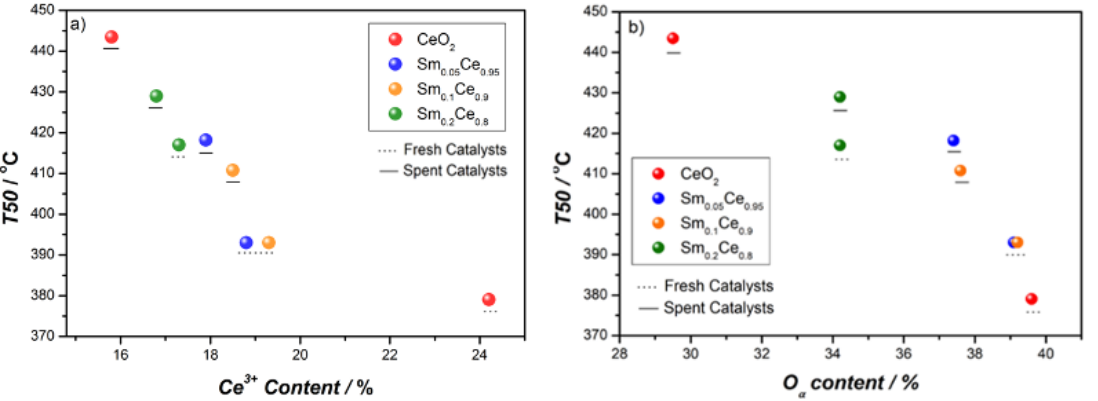
Figure 6. Effect of Ce 3+ percentage and O α percentage on activity for all catalysts: ( a ) T50 vs. Ce 3+ percentage, ( b ) T50 vs. O α percentage.